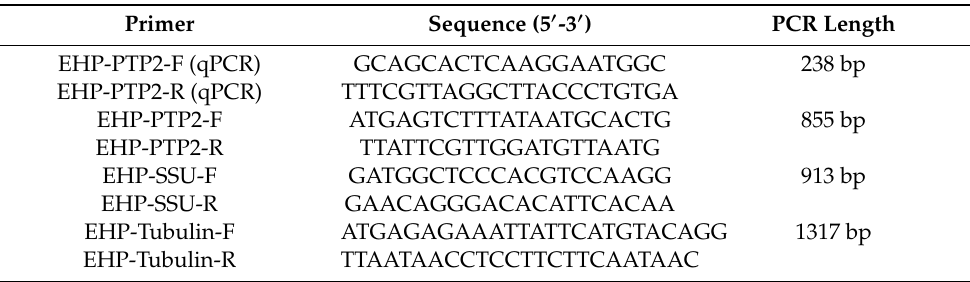
Table 1. The primer sequence in this study.